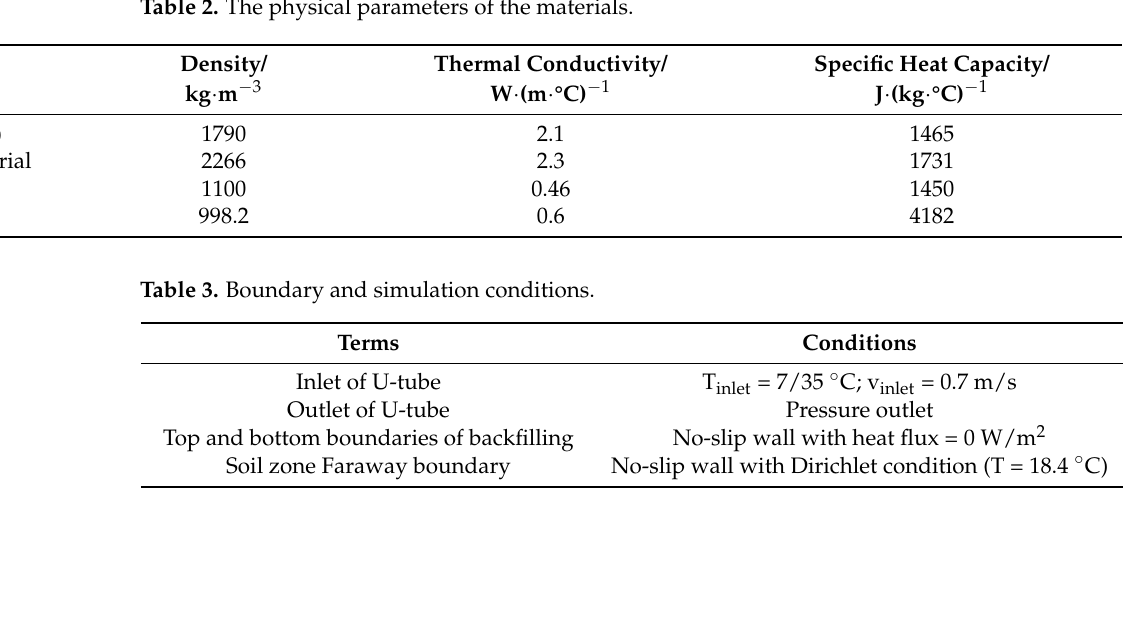
Table 2. The physical parameters of the materials.